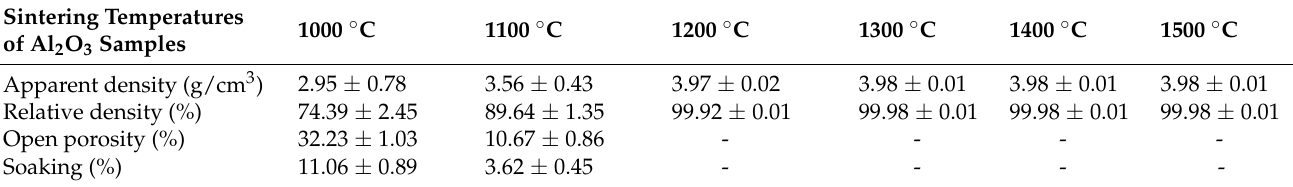
Table 2. Selected properties of Al 2 O 3 samples obtained by the PPS